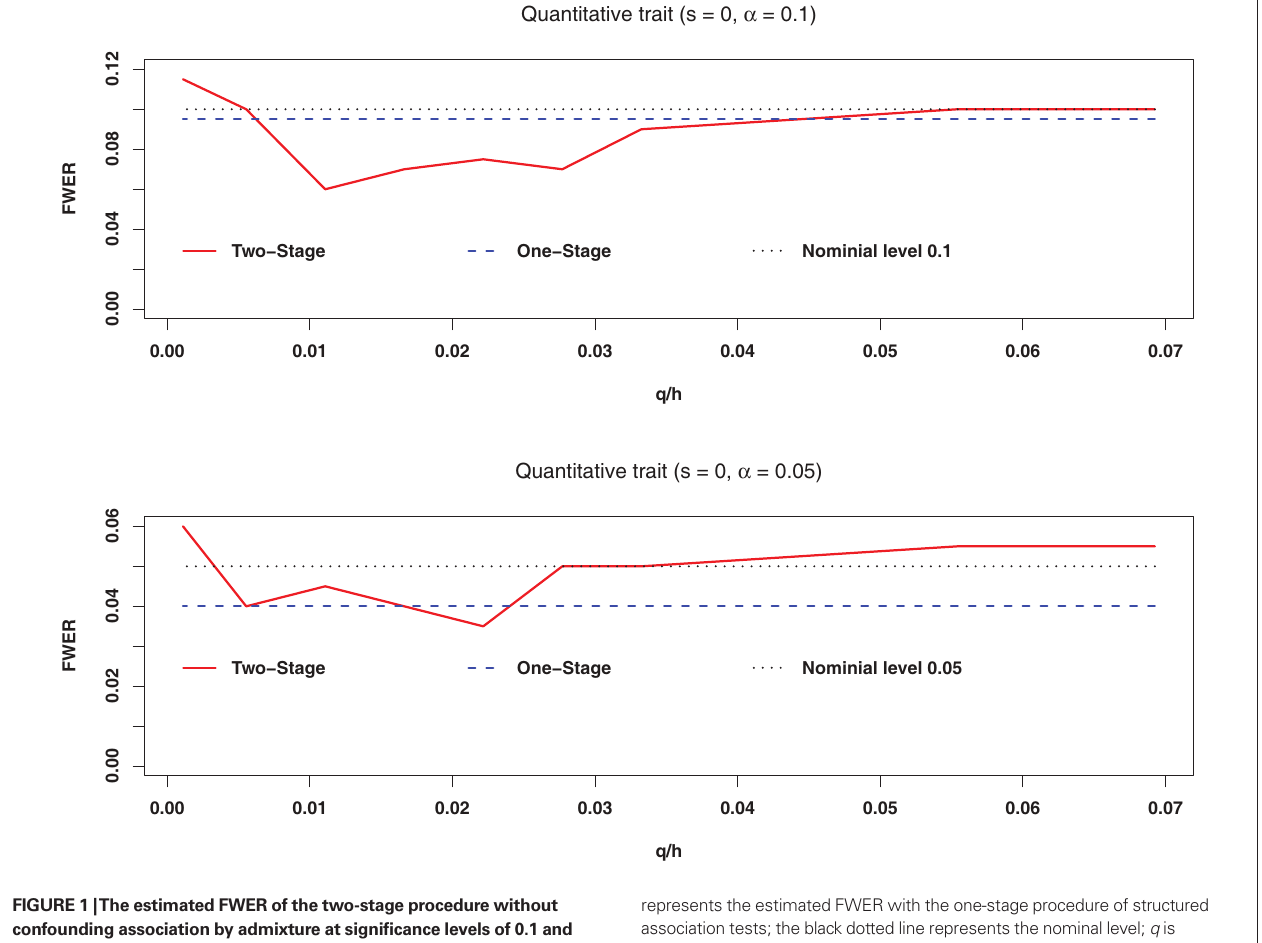
represents the estimated FWER with the one-stage procedure of structured association tests; the black dotted line represents the nominal level; q is the number of SNPs selected in the first stage; and h is the number of total